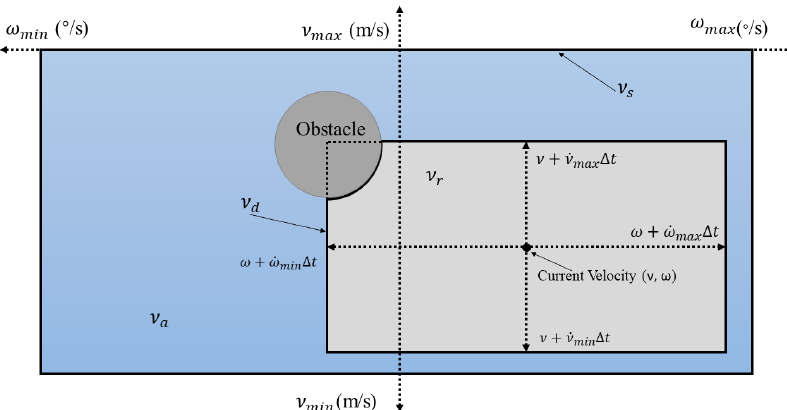
Figure 1. The velocity vector space diagram of the DWA.